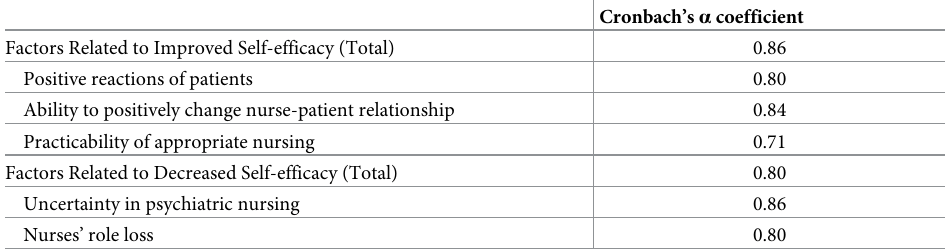
Table 4. Internal consistency of factors related to self-efficacy among psychiatric